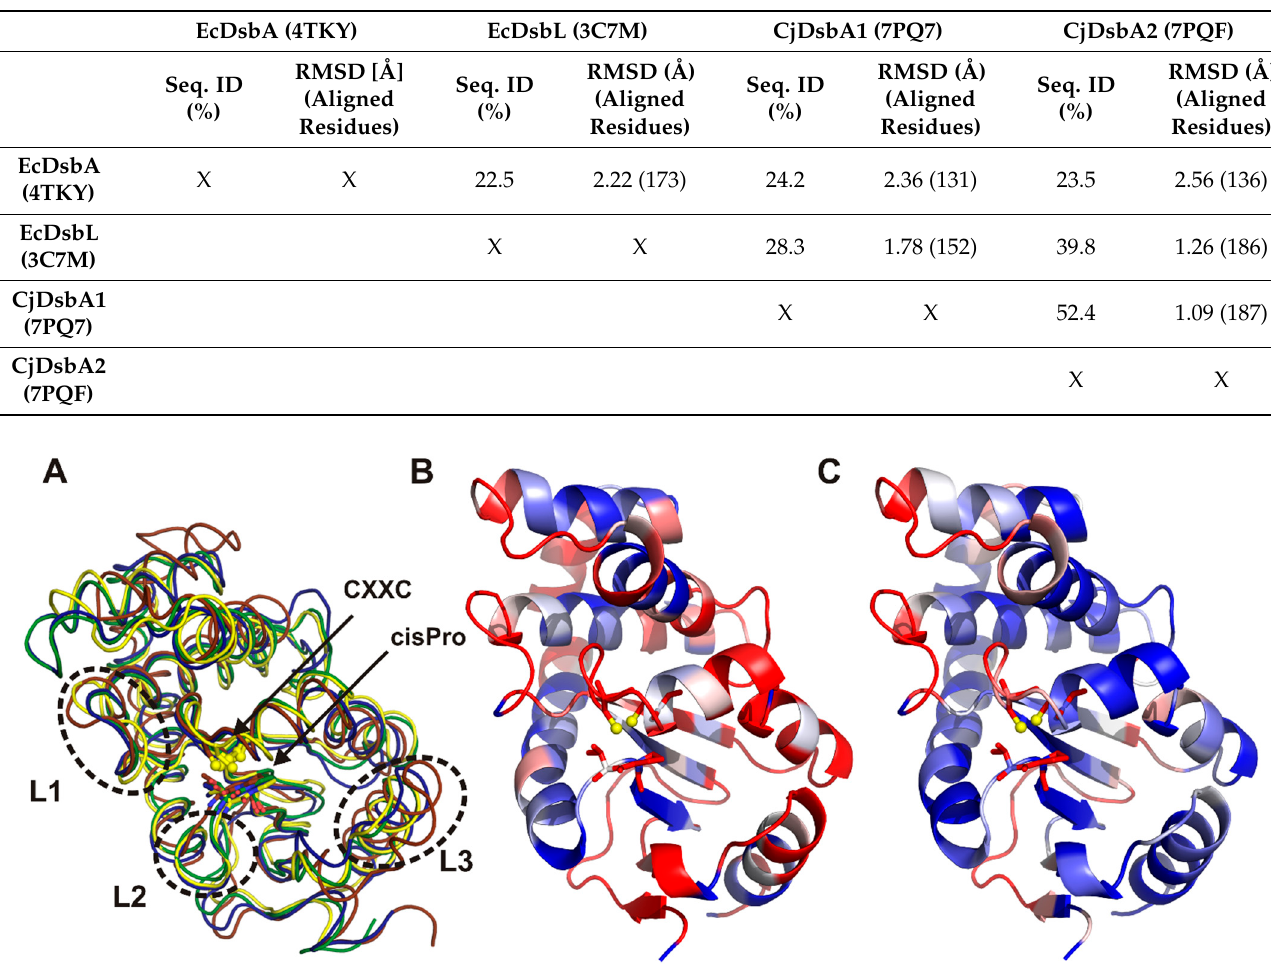
Table 2. Pairwise structure and sequence comparison of E. coli and C. jejuni Dsb proteins. (In brackets are protein’s PDB IDs: 4TKY—DsbA from E. coli [41], 3C7M—DsbL from E. coli [24], 7PQ7—DsbA1 from C. jejuni , 7PQF—DsbA2 from C. jejuni ).